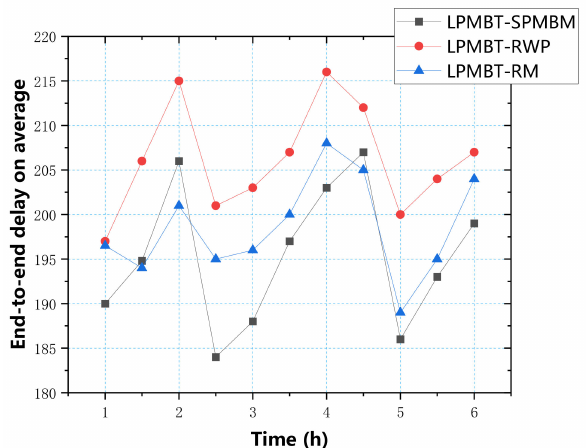
Figure 11. Energy consumption in three mobile models.